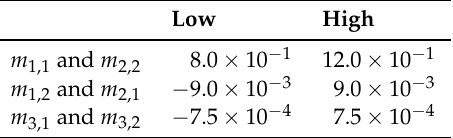
Figure 4. Dataset generation process. The cropped image ˘ I is reconstructed based from its estimated transformation matrix inverse. Yellow bounding box shows the region of ˘ I in the distorted image. The corrected image, I , serves as the ground-truth. Table 1. Range of transformation matrix values used for generating distorted images. The dataset follows a uniform distribution.